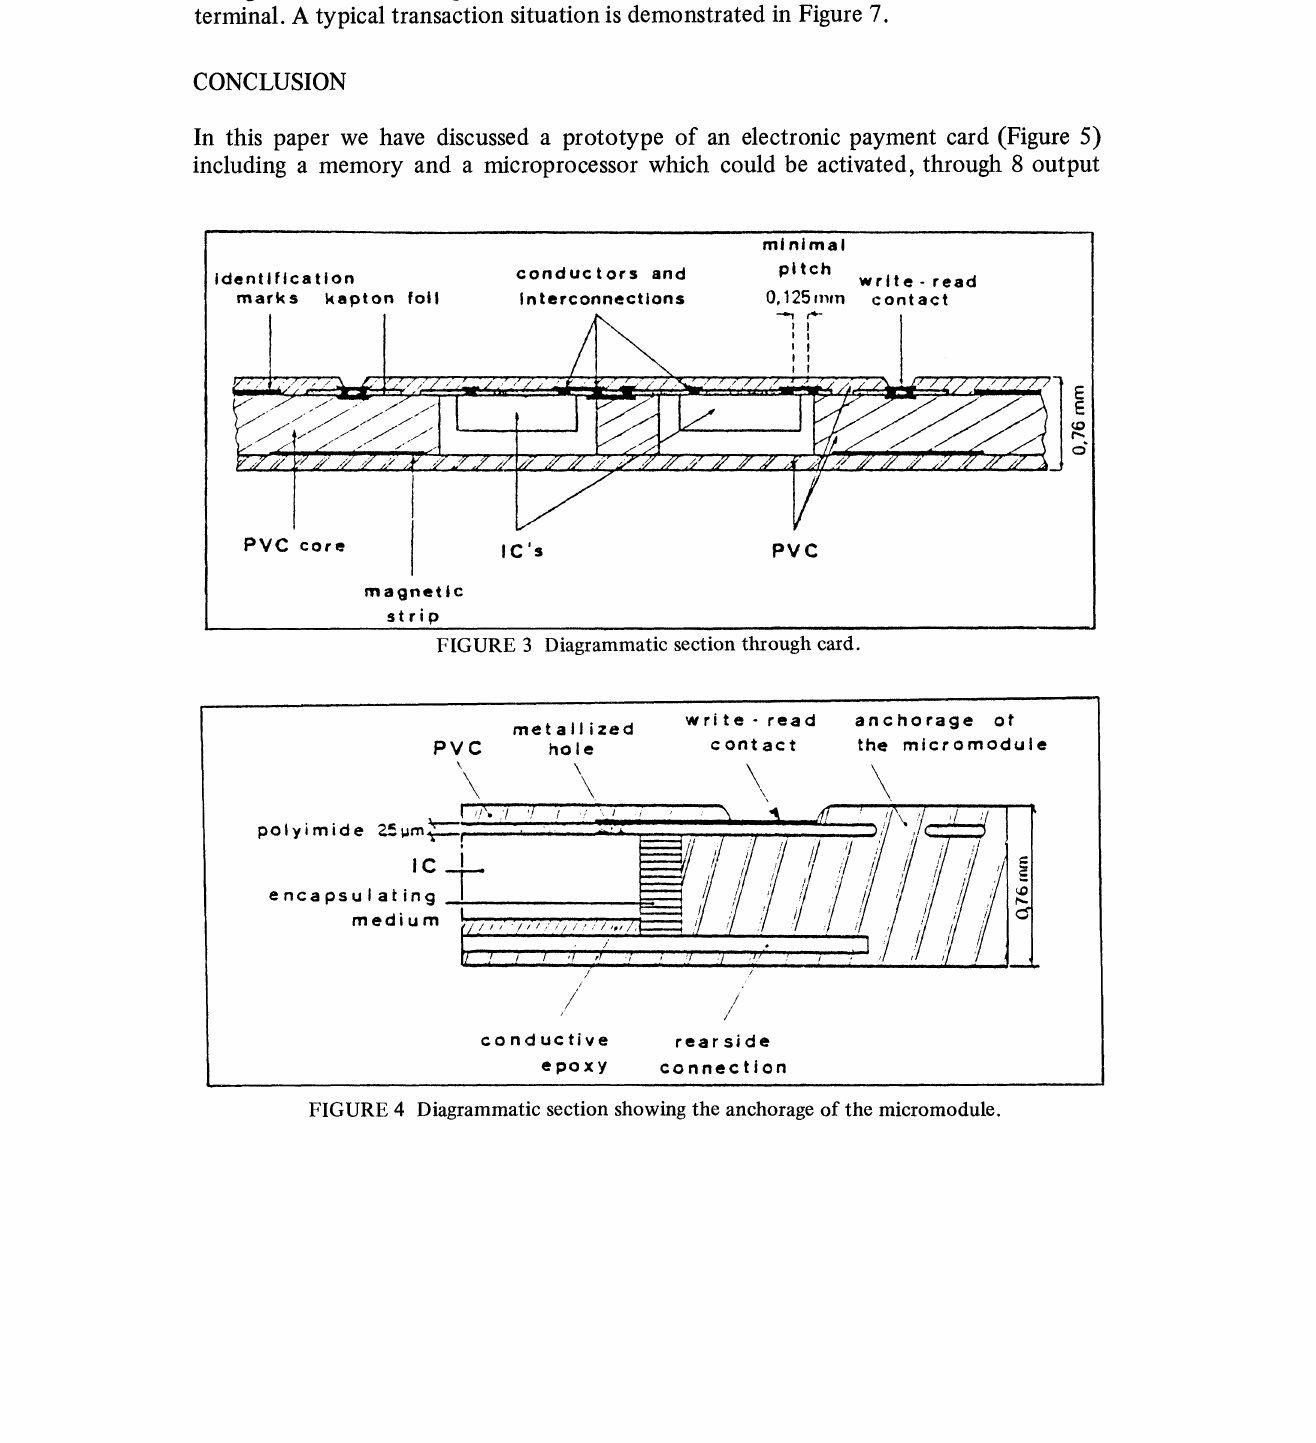
FIGURE 4 Diagrammatic section showing the anchorage of the